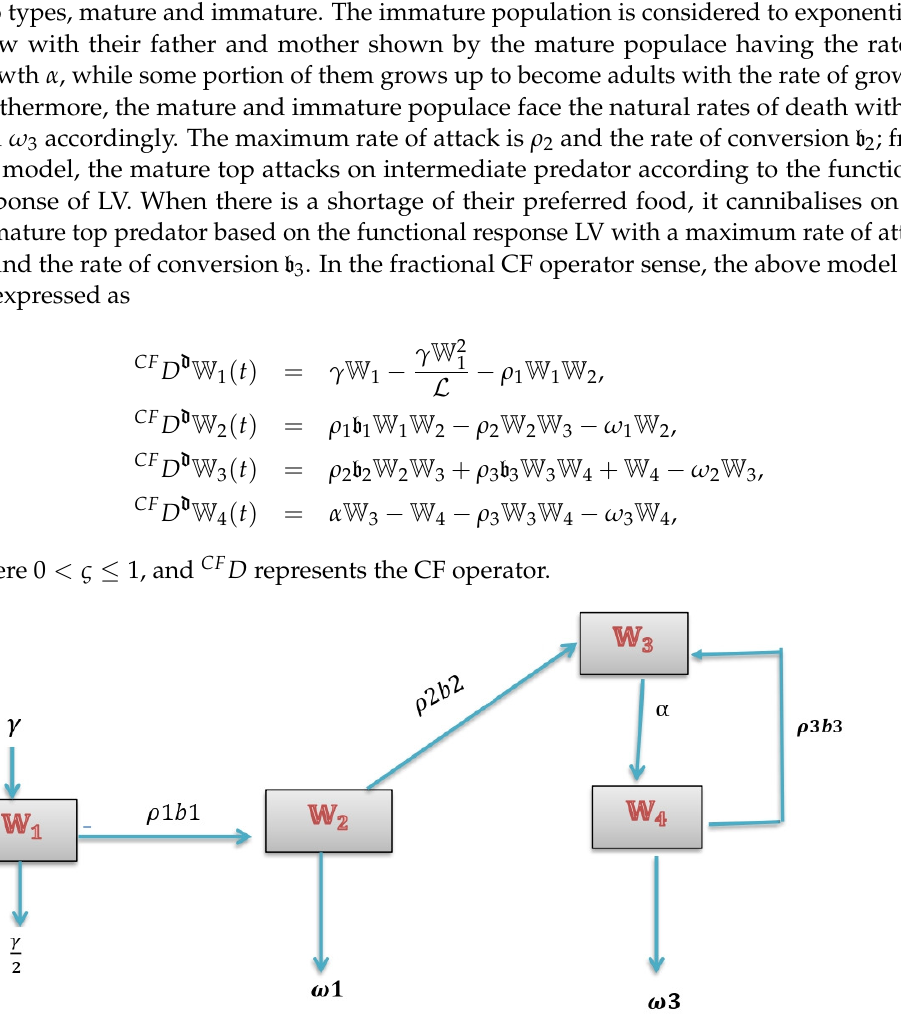
Figure 1. The flowchart of the model